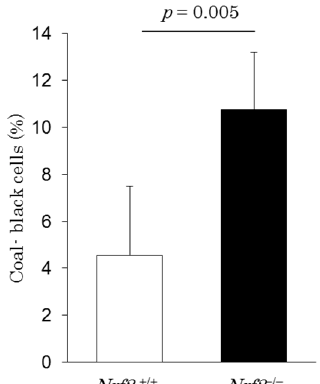
Figure 3. The coal-black alveolar macrophages in the BALF on day 10 after BLM injection and after exposure to DE for 38 days. The vertical axis shows percentage of coal-black alveolar macrophages, in which DEP accounted for more than half of the cytoplasm, such as those indicated in Figure 2B (arrowhead), in the total DEP-laden alveolar macrophages. Data are shown as mean ± SD values in each group ( n = 5).